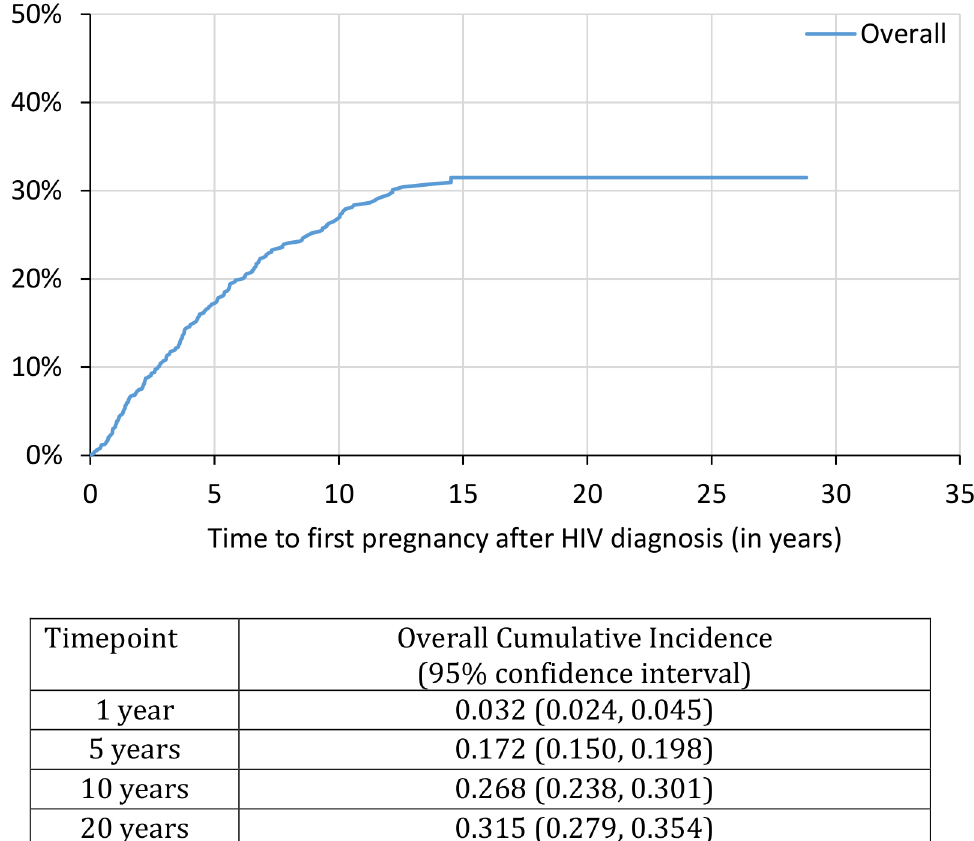
Fig 1. Time to first pregnancy after HIV diagnosis. This figure demonstrates the estimated time to first pregnancyevent (inclusiveof live births, terminationsand miscarriages/stillbirths) for all women living with HIV in our sample that providedHIV diagnosisdate and estimated date of pregnancy (n = 1,136). This figure demonstrates the cumulative incidenceestimates and 95% confidenceintervals at 1-, 5-, 10-, and 20-yearsfor any